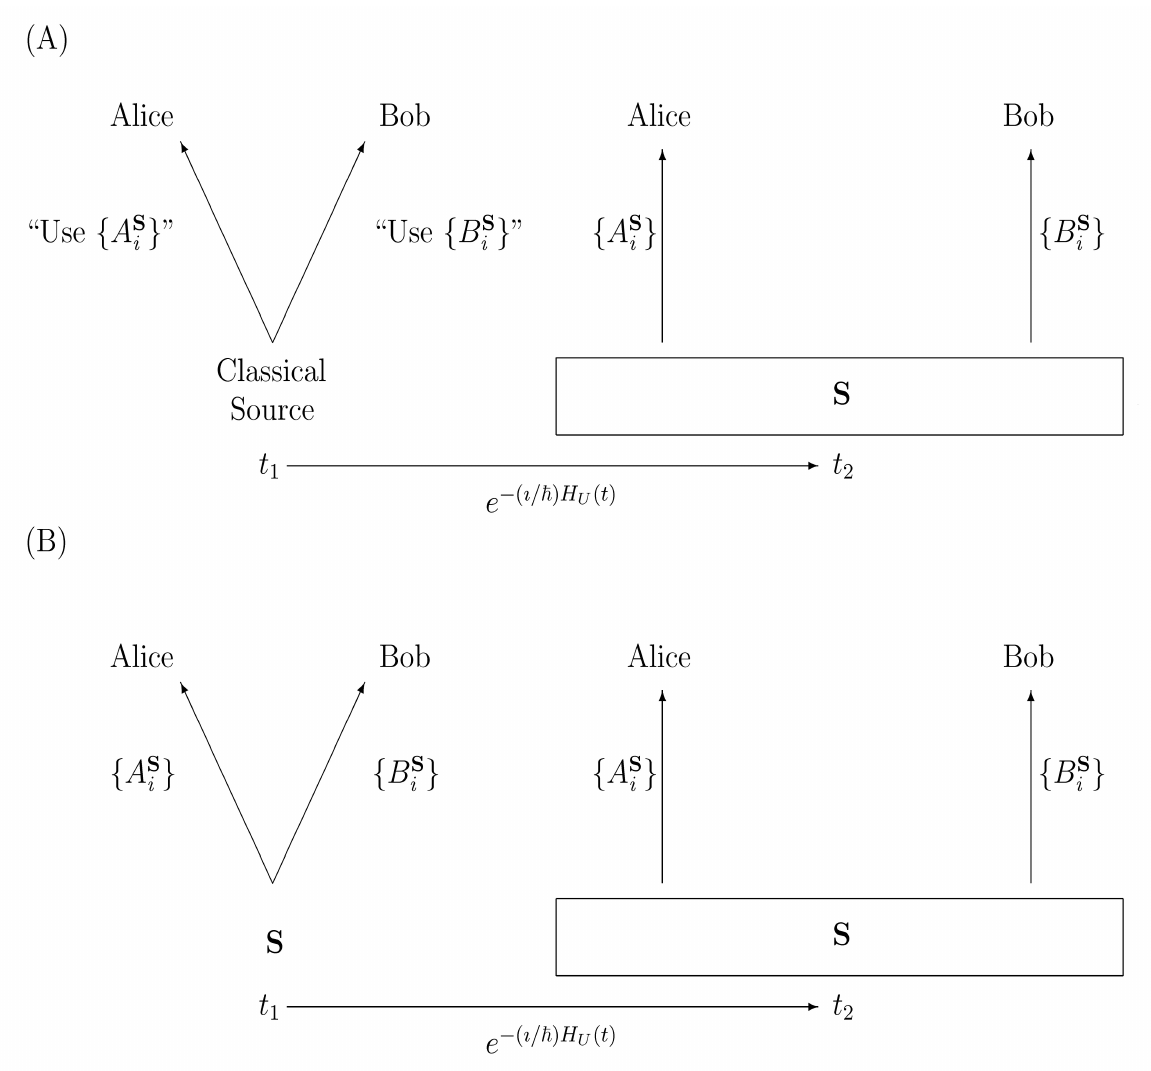
} and { B S } by Alice i i